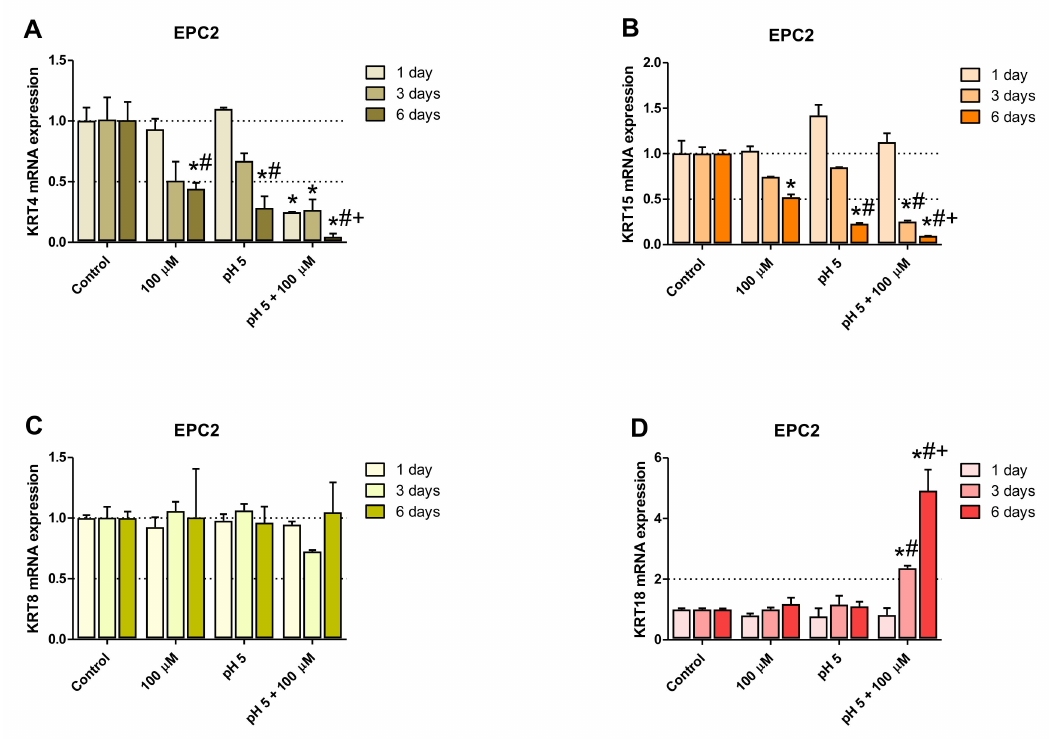
Figure 3. The e ff ect of treatment with bile mixture (BM), acidified medium alone or acidic BM for one, three and six consecutive days on KRT4 , 15 , 8 and 18 mRNA expression in EPC2 cell line. EPC2 cell line underwent 30 min of daily incubation with BM at concentration of 100 µ M, acidified medium to pH 5.0 alone or BM (100 µ M) in acidified medium (pH 5.0) for one, three or six consecutive days and expression of KRT4 , KRT15 , KRT 8 and KRT18 mRNA was analyzed by real-time PCR ( A – D ). PCR reaction was performed in duplicates and quantified using ACTB / GAPDH as reference genes. Data from three independent experiments are shown as the mean ± SEM. An asterisk (*) indicates a significant change as compared with untreated control cells ( p < 0.05). Significant change ( p < 0.05) in gene expression as compared with one day exposure for respective treatment regime is indicated by hash (#). A cross ( + ) indicates a significant change as compared with cells after three days of treatment ( p <